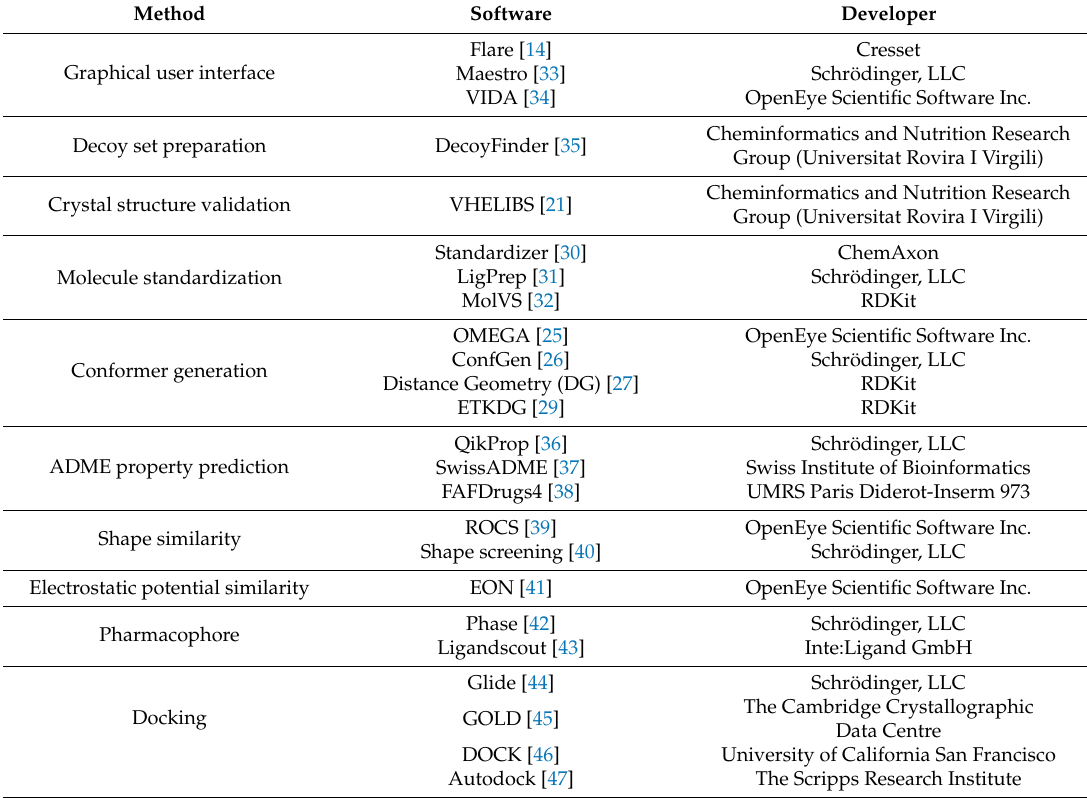
Table 1. Popular and useful software used in the different steps involved in a virtual screening workflow. A more complete list can be found at